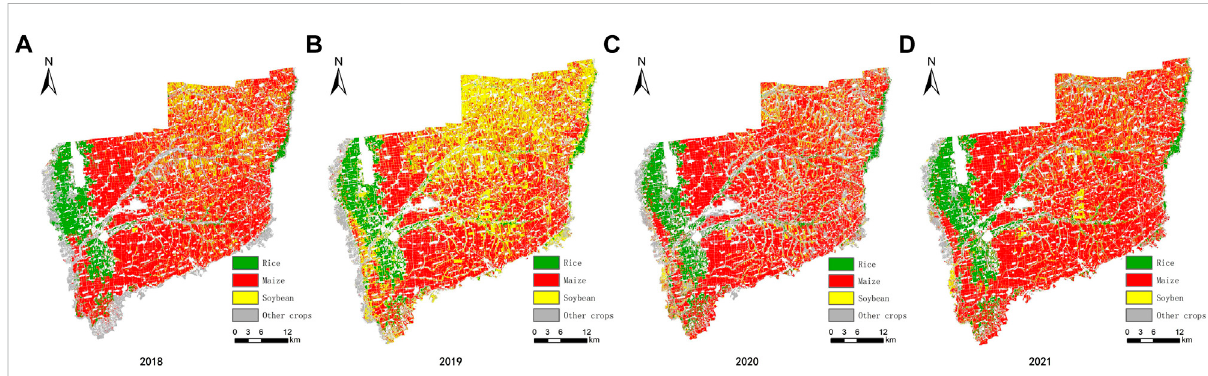
FIGURE 4 Spatial distribution of the crops: rice, maize, soybean and other crops in Wangkui County from 2018 to 2021.